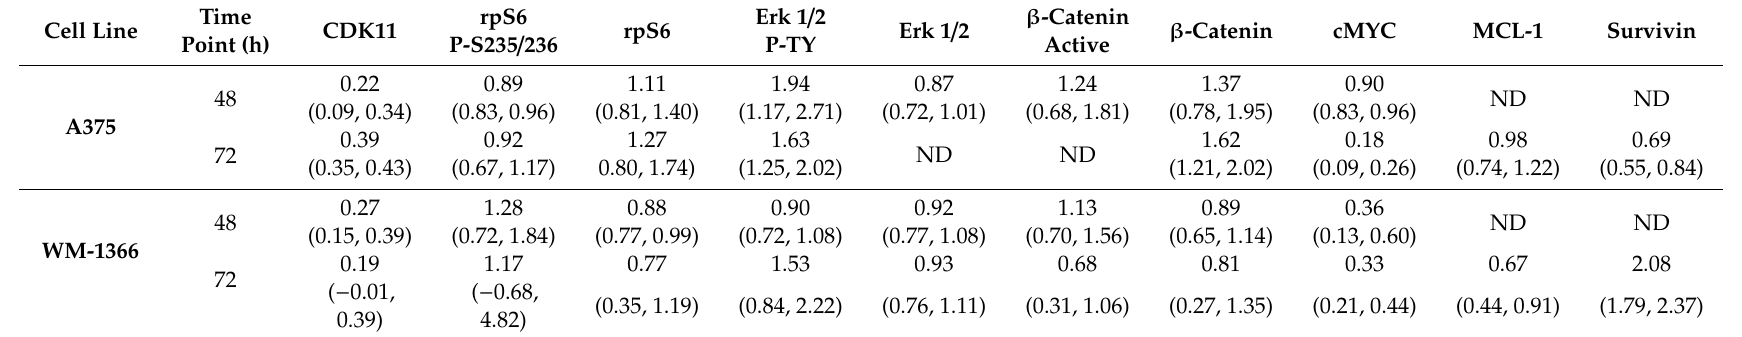
Table 3. Protein expression levels following siCDK11 transfection in certain melanoma